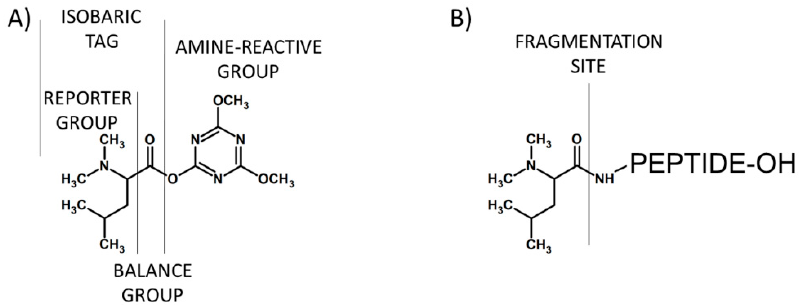
Figure 6. N , N -dimethyl leucine (DiLeu) tag ( A ) developed by Xiang and co-workers [10] and DiLeu modified peptide ( B ).